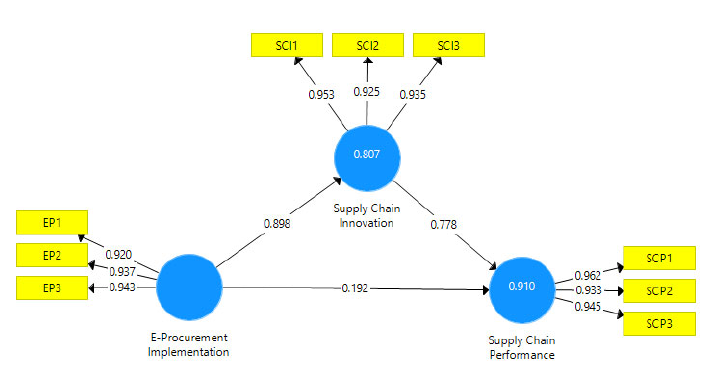
Fig. 3. Validity Test After